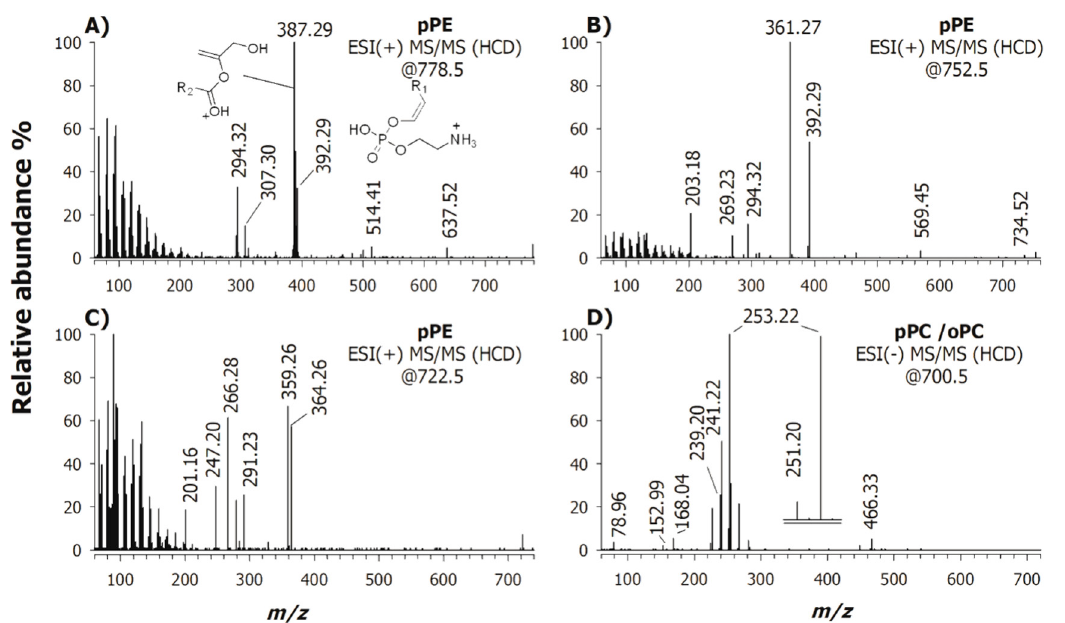
Figure 5. ESI-MS/MS (normalized collisional energy used: 35%) spectra obtained for the potential four plasmalogen biomarkers of PD pathology. ESI (+) FT-MS/MS spectra of ( A ) pPE at m/z 778.5, ( B ) m/z 752.5, ( C ) m/z 722.5, and ( D ) (–) FT-MS/MS spectrum of pPC at m/z 700.5.